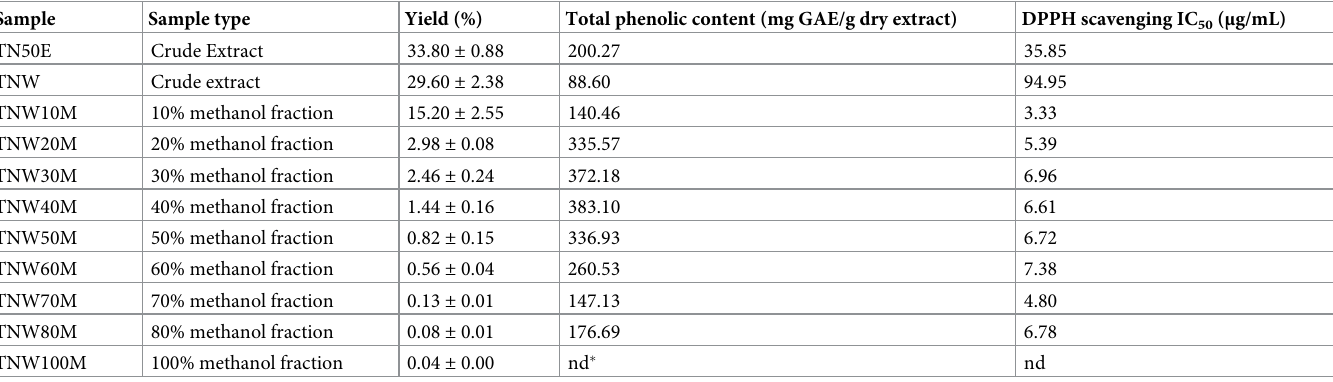
Table 1. Yields of total TN extracts and methanol fractions (% w/w), total phenolic content, and antioxidant activity. Sample Sample